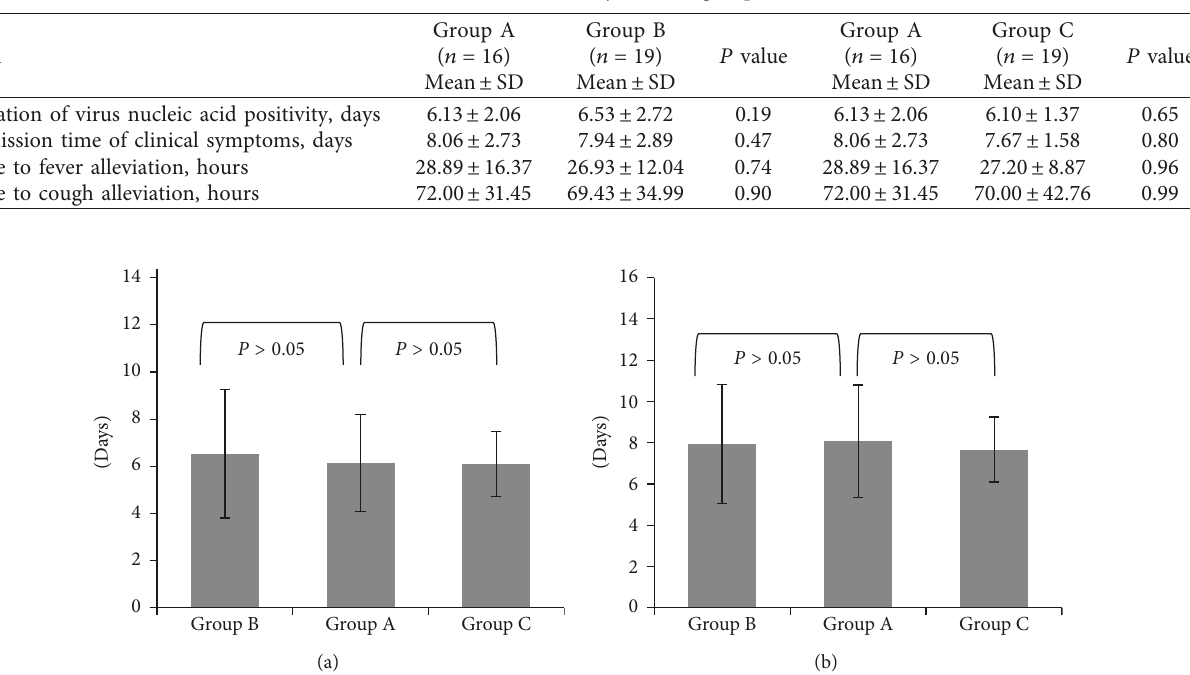
Figure 1: Duration of virus nucleic acid positivity (a) and remission time of clinical symptoms (b) in groups A, B, and C.